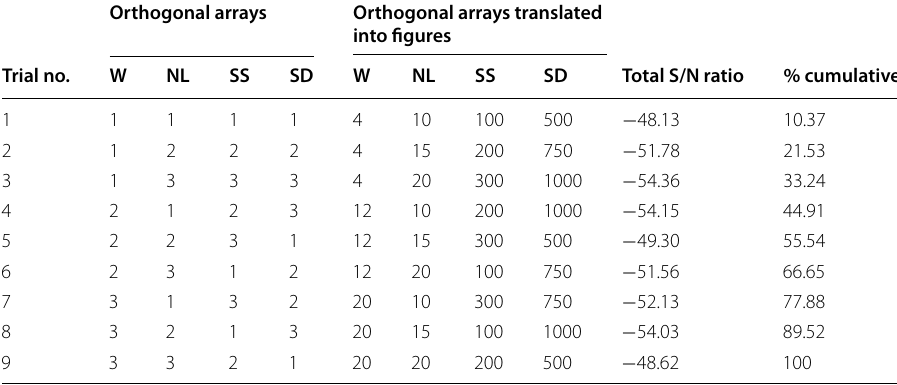
Key: Boron nitride ( W ), %wt; normal load ( NL ), N; sliding speed (SS), rpm; sliding distance ( SD ), m (data is taken from Kumar and Reddy [13])